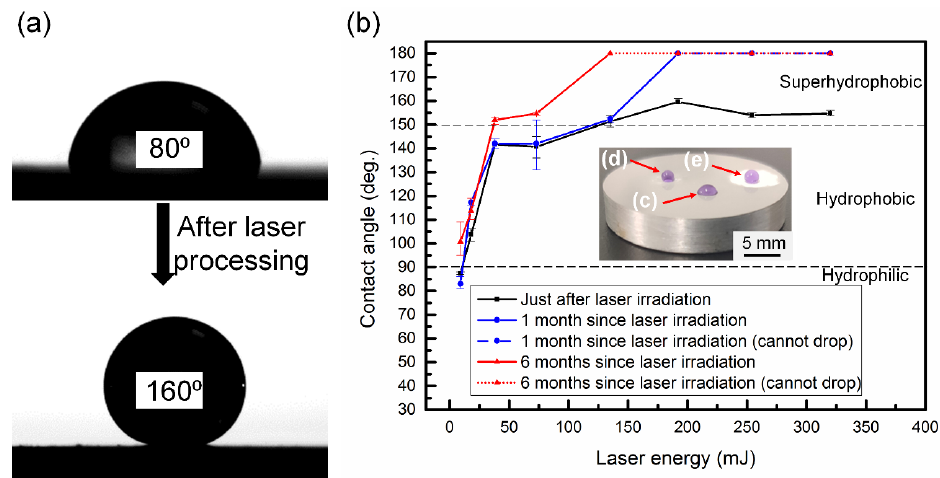
Figure 4. ( a ) Measured surface wettability of the aluminum target after the single-shot nanosecond laser irradiation at the pulse energy of 192 mJ; ( b ) Measured surface wettability of the aluminum target after the laser processing, after 1 month and 6 months since the laser processing with different laser energies; ( c ) Water droplet on the area before the laser processing; ( d ) Water droplet on the low-laser-energy treated area; and ( e ) Water droplet on the high-laser-energy treated area. Interestingly, the laser-treated area with the laser energy of 9 mJ converted from hydrophilicity to hydrophobicity six months after the laser beam interaction. Therefore, after the interaction between the single laser pulse and the aluminum target, the material surface became hydrophobic or superhydrophobic, depending on the treated energy. This hydrophobic or superhydrophobic property has continuously enhanced itself over time since the laser irradiation. Video S1 illustrated the wettability conversion before and after the laser processing, as well as the enhancement of superhydrophobic properties after one month and after six months since the laser irradiation. An impact test with water droplets was performed on the sample just after laser ablation, as shown in Video S2. After dropping 18 droplets, a small amount of water started to adhere to the surface. Although the surface became superhydrophobic just after laser ablation, the superhydrophobic performance was not high, which was demonstrated through the contact of the droplet on the surface in Video S1 and the droplet impact test in Video S2. In addition, the wettability conversion on Al, the surface wettability conversion from hydrophilicity to hydrophobicity after irradiating with a single-shot laser beam, was also found on stainless steel, as shown in Figure S3. However, its hydrophobic property was not stable, but the contact angles persisted at certain values higher than the initial value of the wet-polished surface before the laser irradiation. The reason for this instability as well as the mechanism for wettability conversion on stainless steel might be investigated in further research. 3.4. Mechanism of Wettability Conversion with Single-Shot Nanosecond Laser Irradiation After the laser processing, both the morphology and the chemical compositions of the aluminum surfaces changed, which could provide the mechanism for the wettability conversion from hydrophilicity to superhydrophobicity. When a single laser pulse inter- acted with the aluminum surface, laser energy was absorbed on the surface. At that time, thermal effects on the laser-treated area occurred [37 – 39]. The estimated maximum tem- perature was about 546 °C, as calculated by thermal models [38,40]. The existing oxide layer on the aluminum surface, which was formed by the wet-polishing process, might be modified and accumulated as nanoparticles and sub-microparticles. At the same time, the pure aluminum layer underneath the existing oxide layer was also oxidized, and formed nanoparticles and sub-microparticles due to the nanochemical effects of the pulsed laser interaction with metals [41]. All of the formed particles could act as nanostructures and